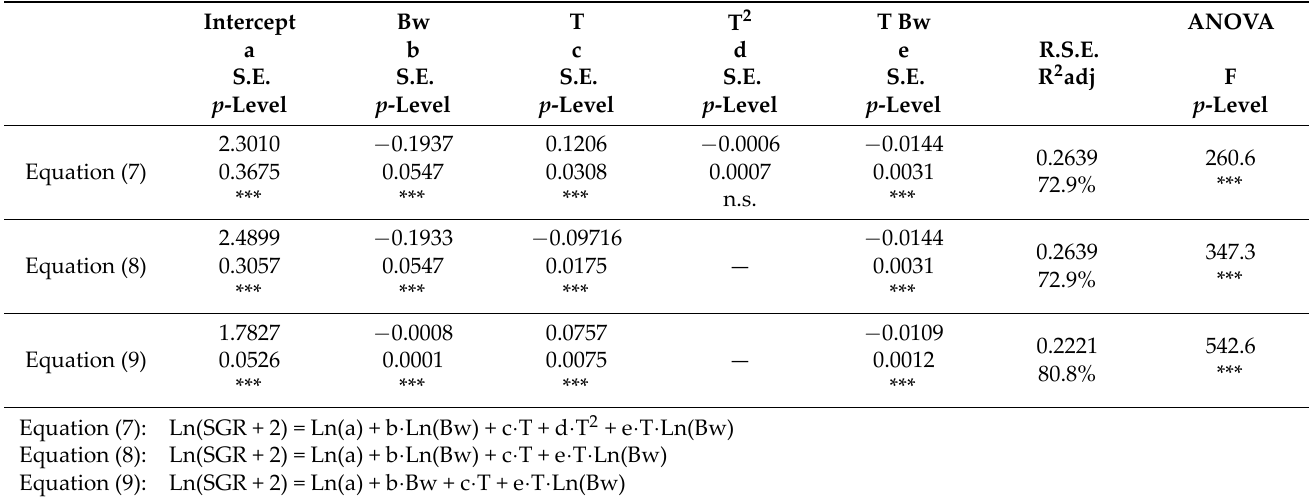
Table 4. Multiple regression analysis results for SGR as dependent variable for the full dataset.